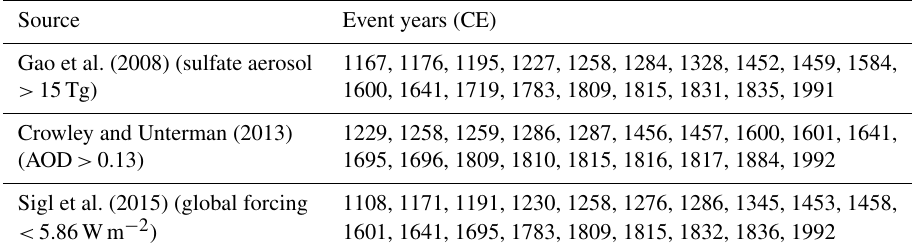
Table 3. Event years used in the superposed epoch analysis (Fig. 4). The event lists are composed of the 20 strongest eruptions from each